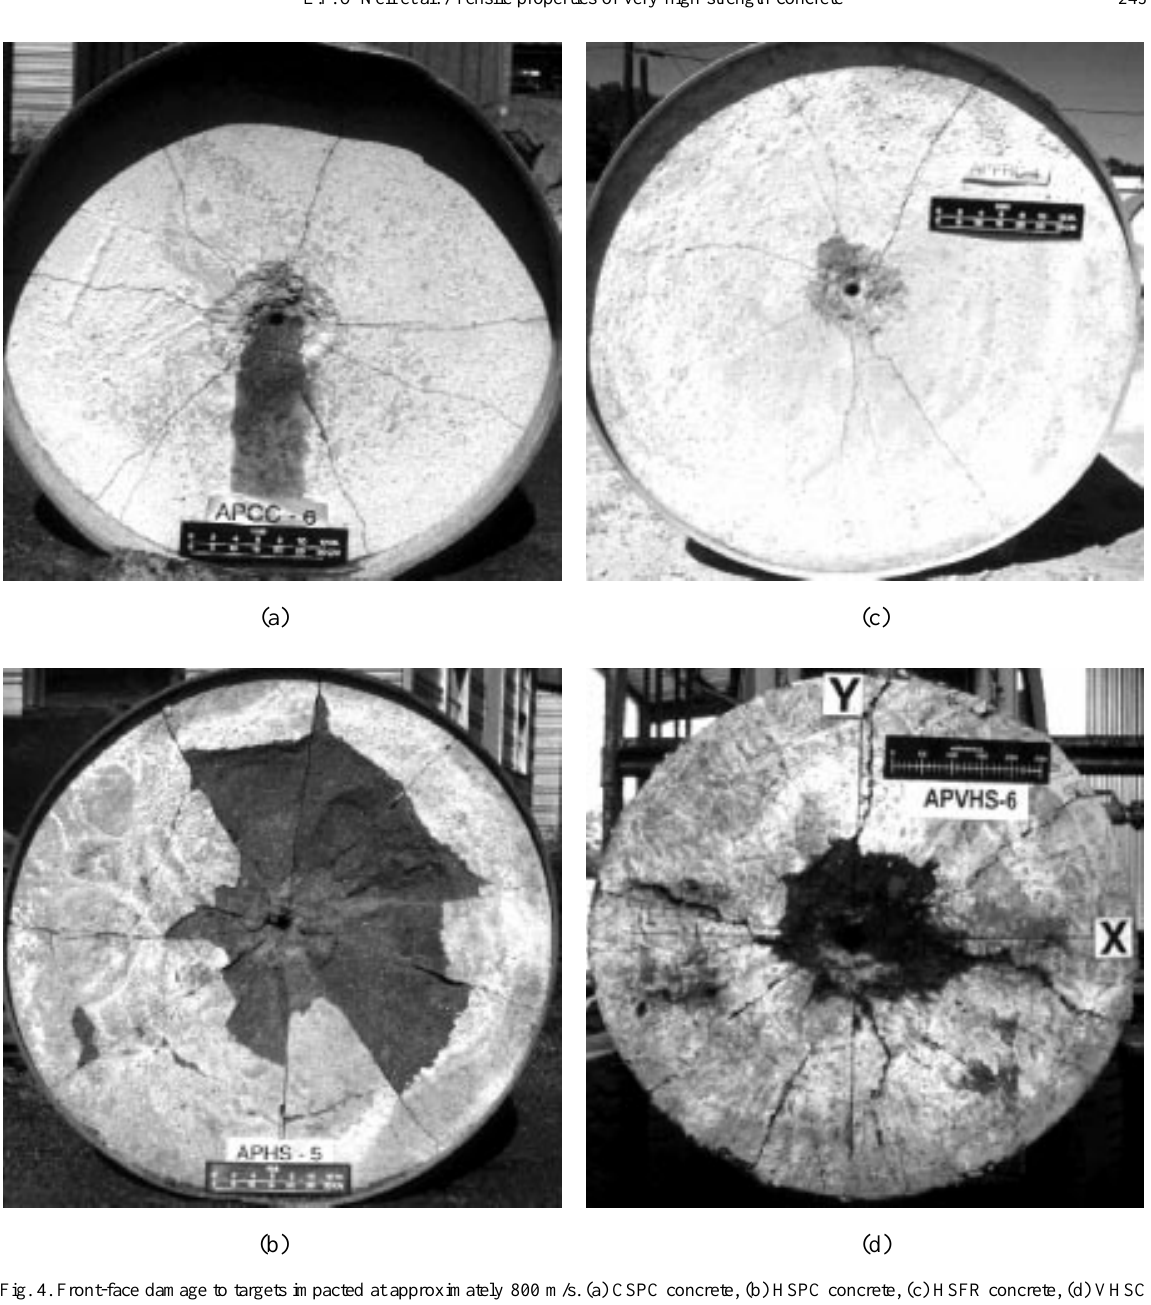
Fig. 4. Front-face damage to targets impacted at approximately 800 m/s. (a) CSPC concrete, (b) HSPC concrete, (c) HSFR concrete, (d) VHSC